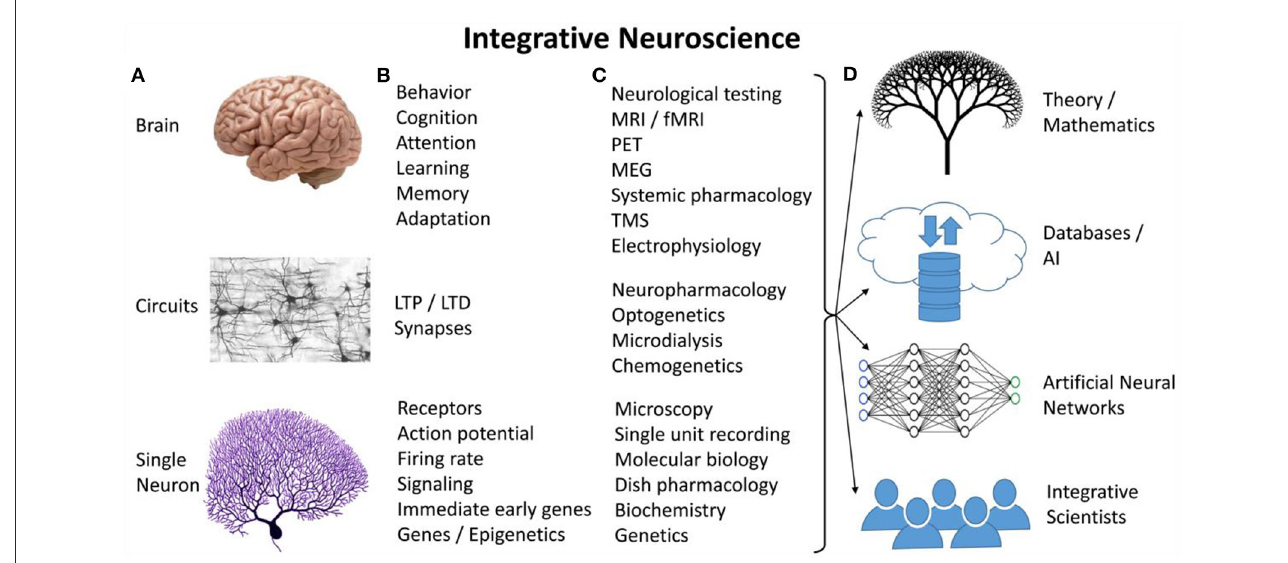
FIGURE1 Integrative neuroscience encompasses multiple levels of analyses (A) , and integrates “big data” (B) collected using diverse methods (C) to uncover relationships and phenomena that transcend levels. (D) Several solutions to the integration